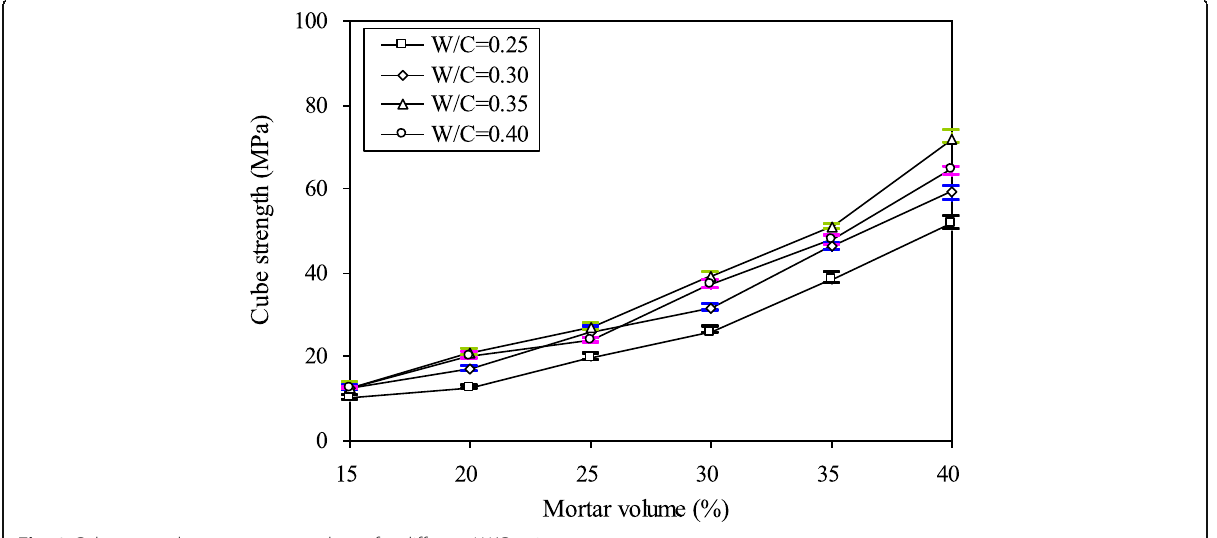
Fig. 9 Cube strength versus mortar volume for different W/C ratios